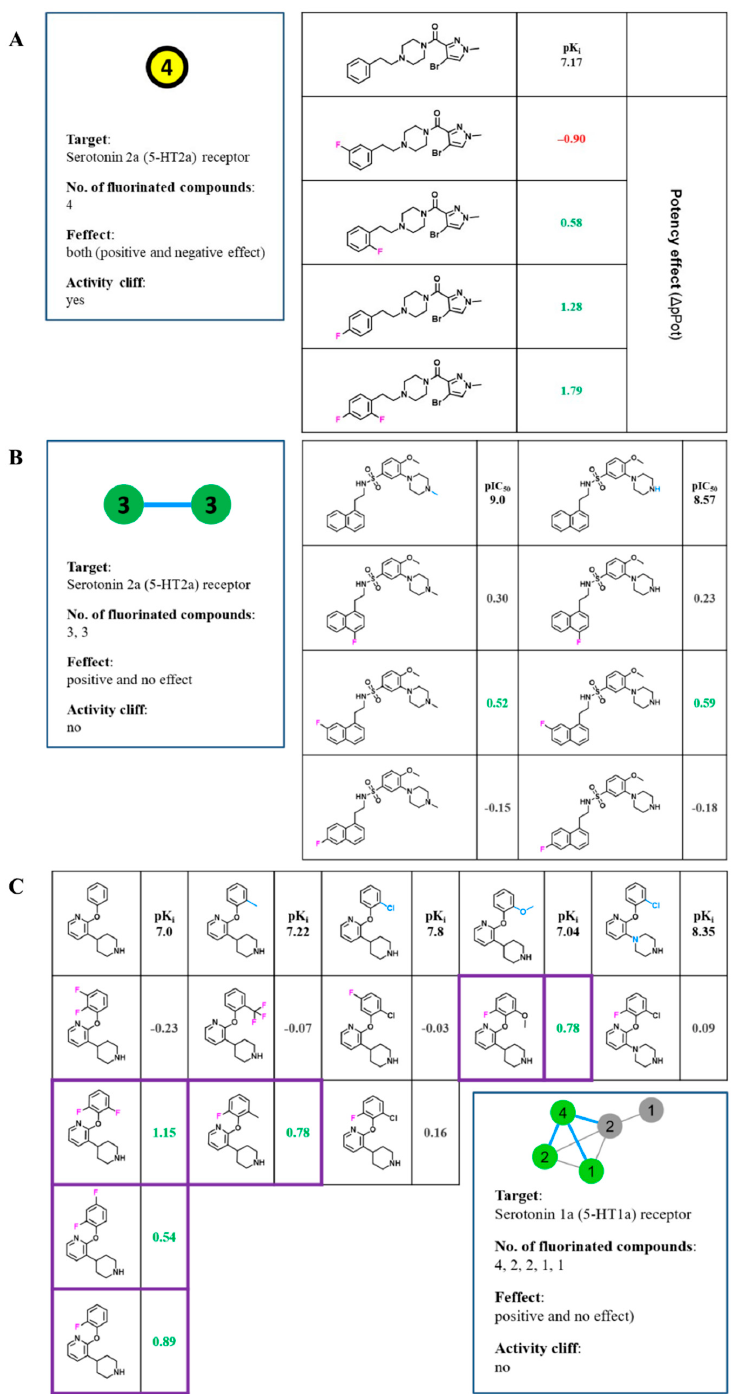
Figure 6. Exemplary FSAR sets from the network. ( A ) The FSAR set consists of one non-F compound and four fluorinated analogues annotated against the serotonin 2a (5-HT2a) receptor. The fluorinated compounds show negative and positive potency effects and the set contains an AC depending on the position of the fluorine atom. ( B ) The pair of FSAR sets comprising a non-F compound and three fluorinated analogues in each case with activity against the 5-HT2a receptor. The FSAR sets differ only in a methyl group and show fluorine substitutions at identical sites with the same positive potency effects. ( C ) A more complex cluster is shown that combines five FSAR sets active against the serotonin 1a (5-HT1a) receptor. The number of fluorinated compounds differs from one to four analogues per set. Three of the five sets have a positive and two no potency effect, although the recurrent ortho position of the fluorine atom (highlighted in purple) always shows a significant positive